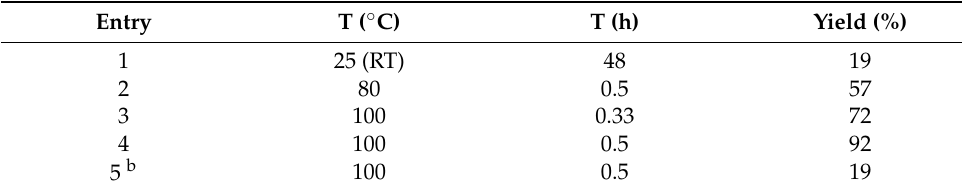
Table 1. Time and temperature reaction optimization a .